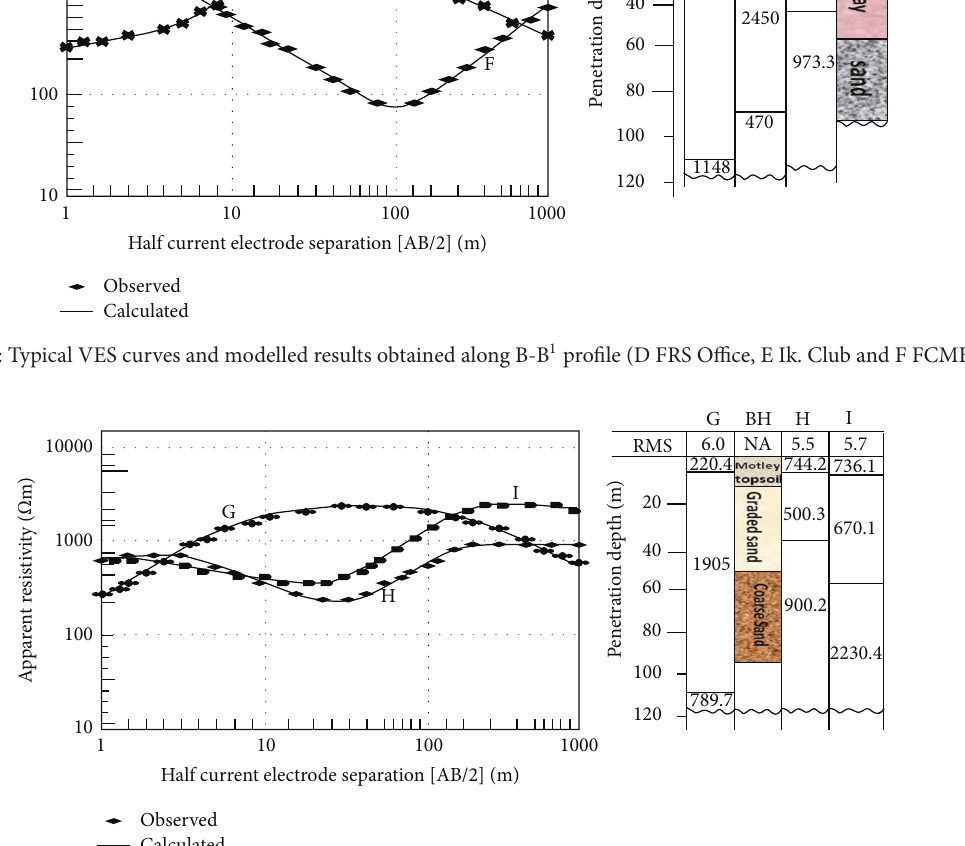
(m)110 Half current electrode separation [AB/2]